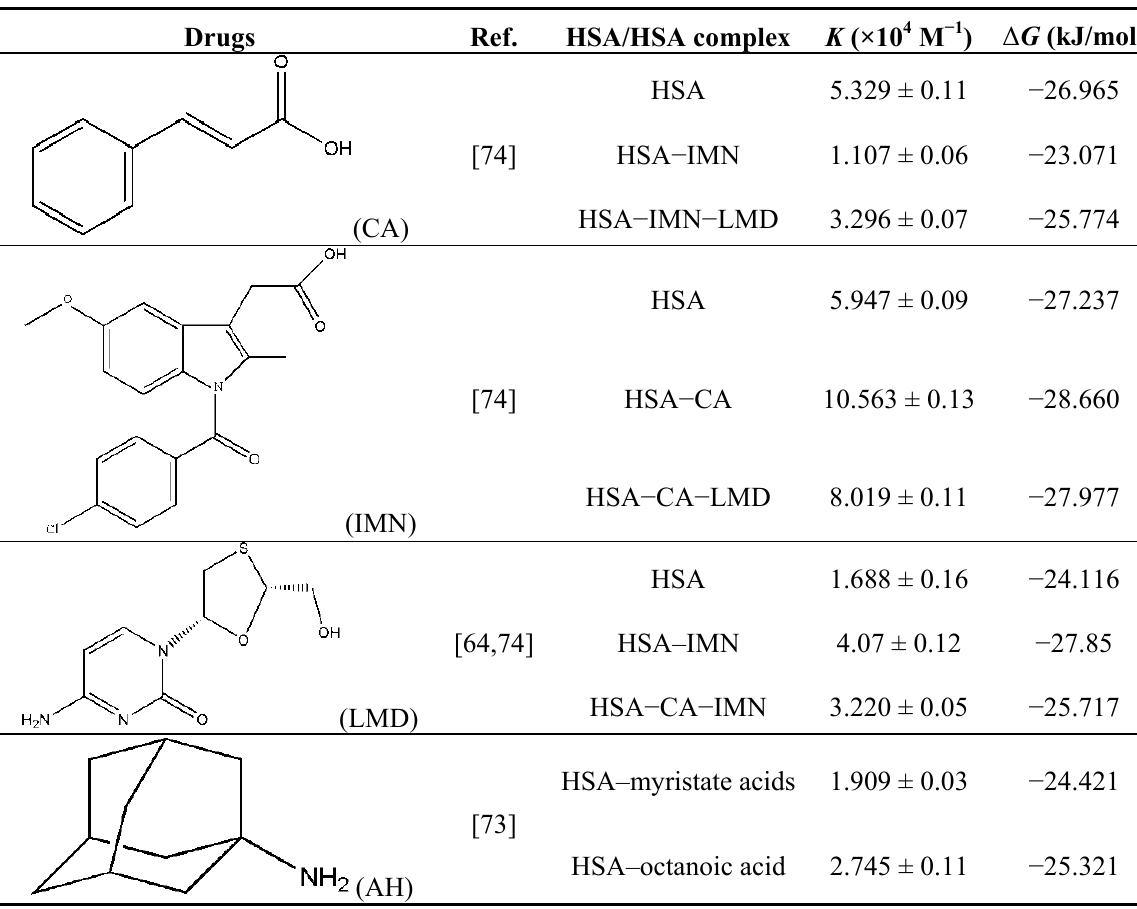
Table 1. The binding constants ( K ) and free energy change ( Δ G ) of HSA and HSA complexes for